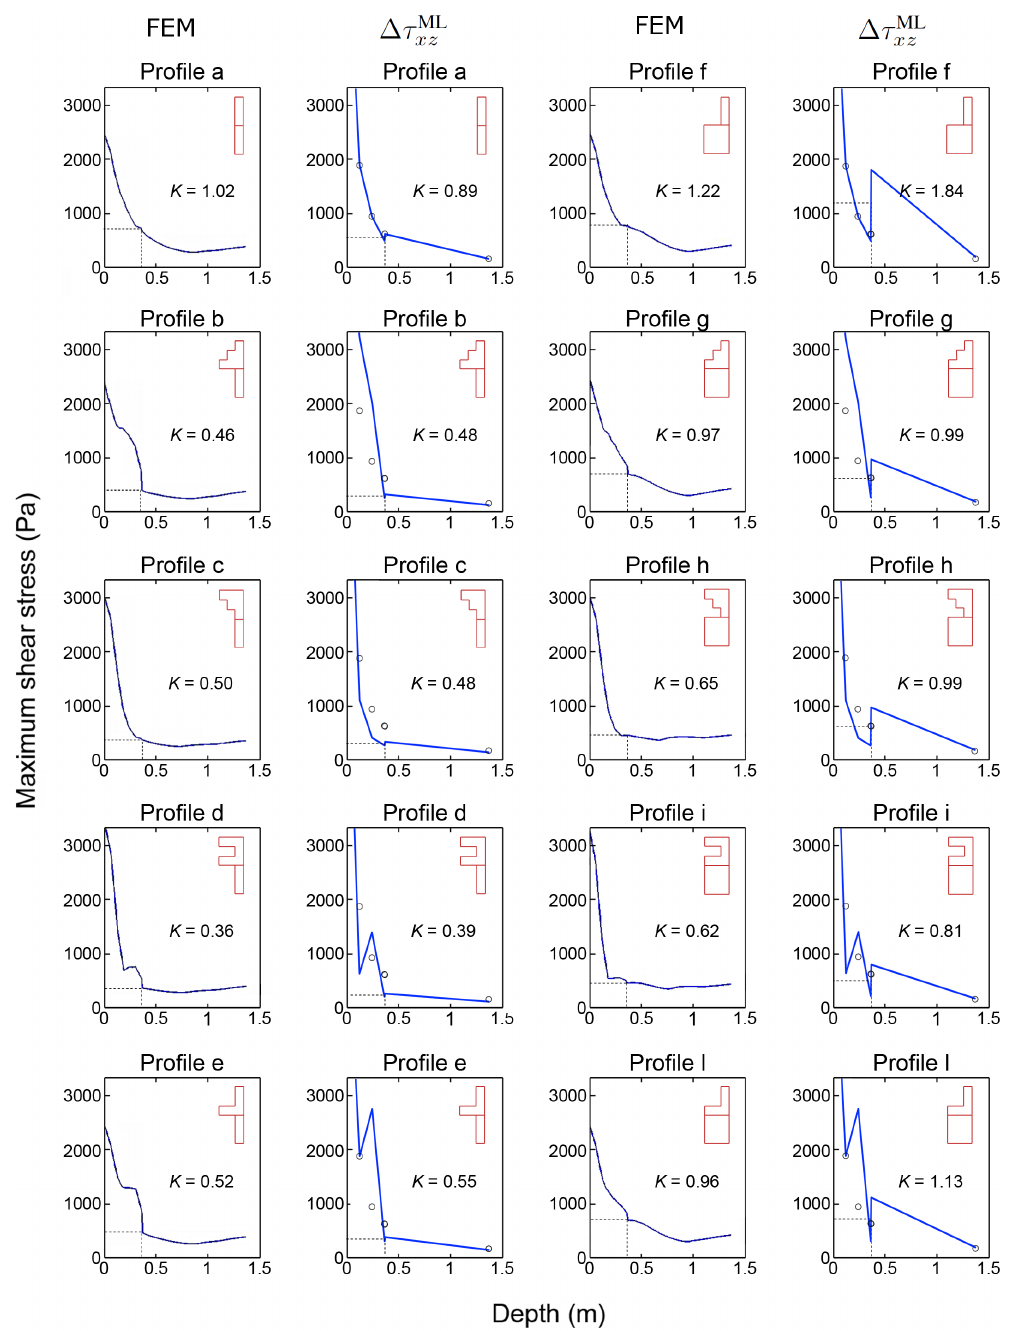
Figure 5. Maximum shear stress vs. depth calculated with FEM (Habermann et al., 2008) and with the proposed approach ( (cid:49)τ ML xz ) for 10 simplified profiles shown in red in the upper right corner. The dotted lines indicate the weak layer position, the black circles indicate the values of the classical analytical solution (Föhn,